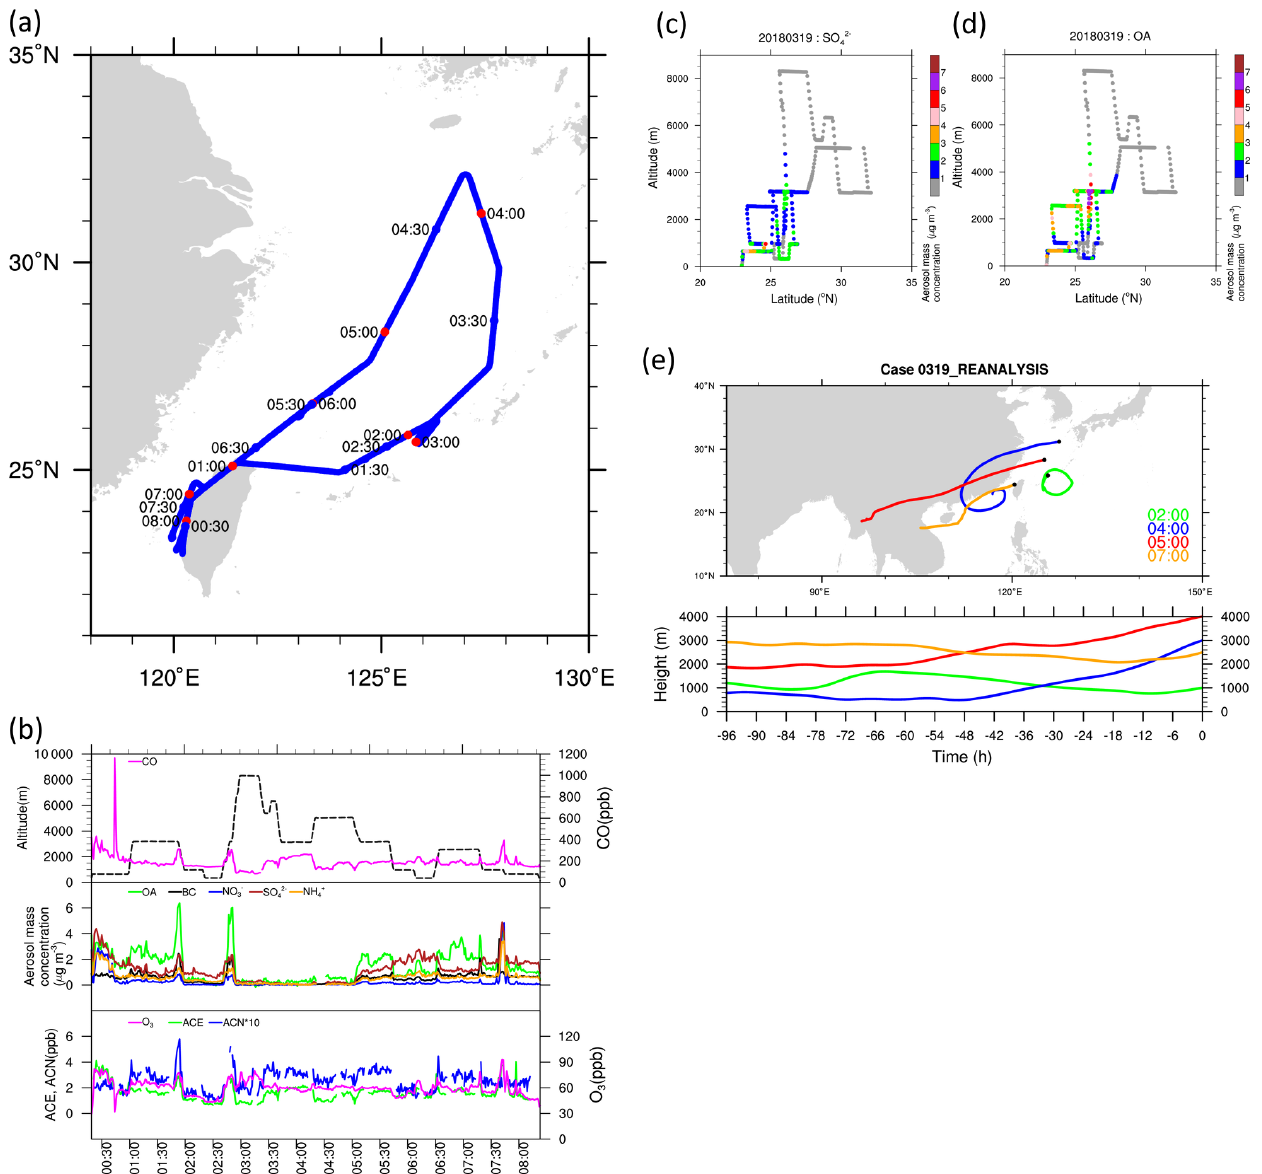
Figure 7. (a) The HALO flight and detailed locations on 19 March. (b) Flight altitude and 1min mean of observed concentrations for CO (upper), organic aerosol (OA), BC aerosol (BC), SO 2 − , NO − , NH + (middle), O 3 , acetone (ACE), and acetonitrile (ACN) (bottom) on 4 3 4 19 March 2018. (c) The observed SO 2 − mass concentration by HALO along with height–latitude variations on 19 March 2018. (d) The 4 observed OA mass concentration by HALO along with height–latitude variations on 19 March 2018. (e) Result of the HYSPLIT model backward-trajectory analysis started at the location of the HALO flight path at 02:00, 04:00, 05:00, and 07:00UTC on 19 March